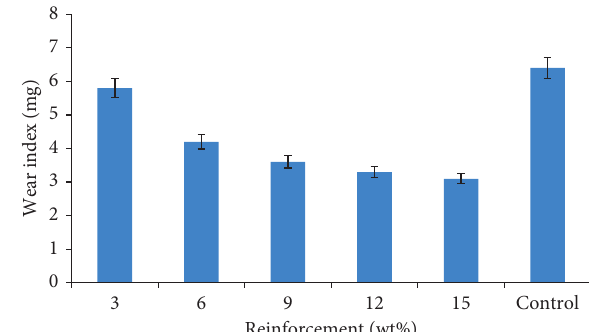
Figure 6: Wear index of the developed composites and the